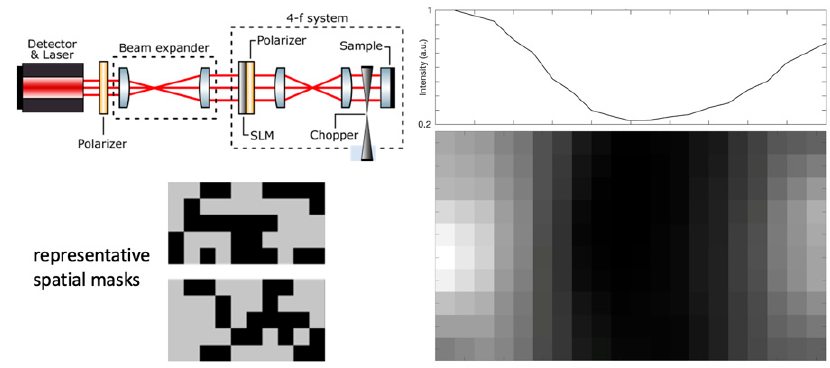
Figure 13. OF scanless image (bottom right) of a metal wire on a mirror surface, taken with the setup sketched at top-left. The OF laser source and detector is an SDL ( λ = 670 nm). The spatial-light modulator is taken from a video projector. Total imaged area 2 × 4 mm 2 . Two representative masks adopted for illuminating the target are shown at bottom-left. The integral over pixel columns of the wire image is shown at top-right (adapted from [60]).